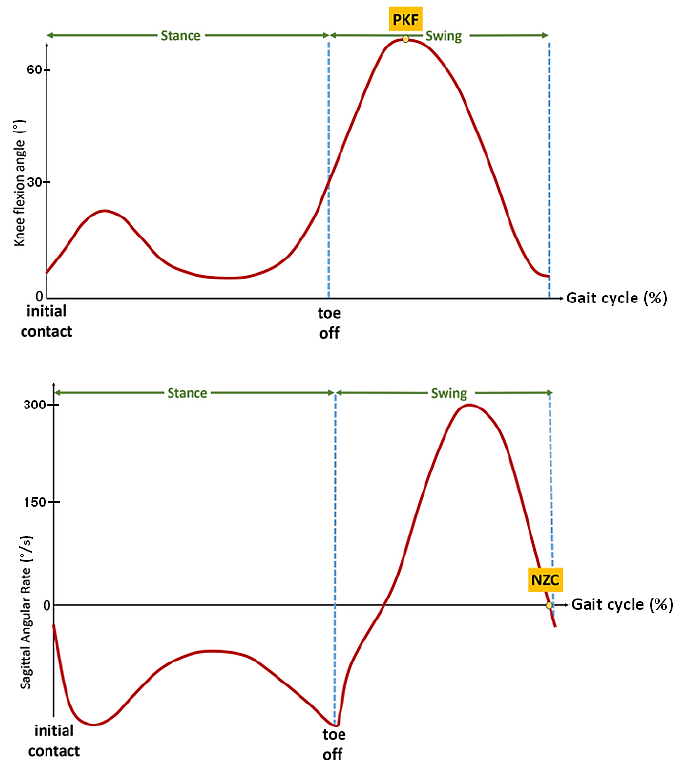
Figure 4. Illustrative figures of the two events to be detected before stance phase. Top: Peak knee flexion (PKF) angle in swing phase, Bottom: negative zero crossing (NZC) sagittal angular rate.